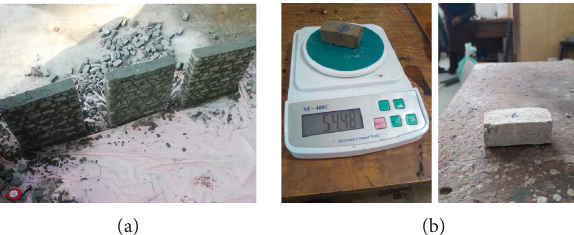
Figure 2: Brick masonry unit and wallettes used for basic testing of masonry constituents. (a) Masonry wallettes. (b) Brick